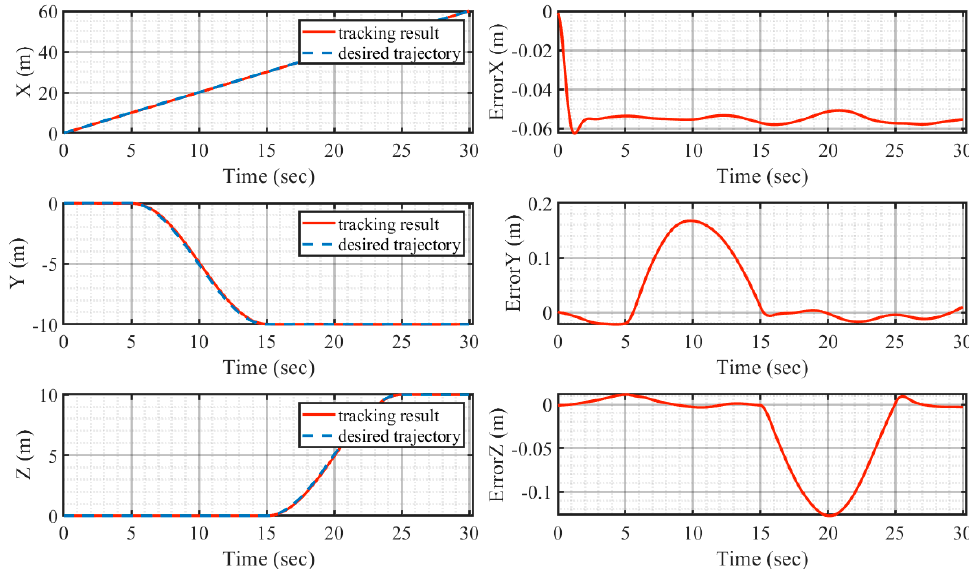
Figure 13. Tracking results ( left ) and tracking errors ( right ).